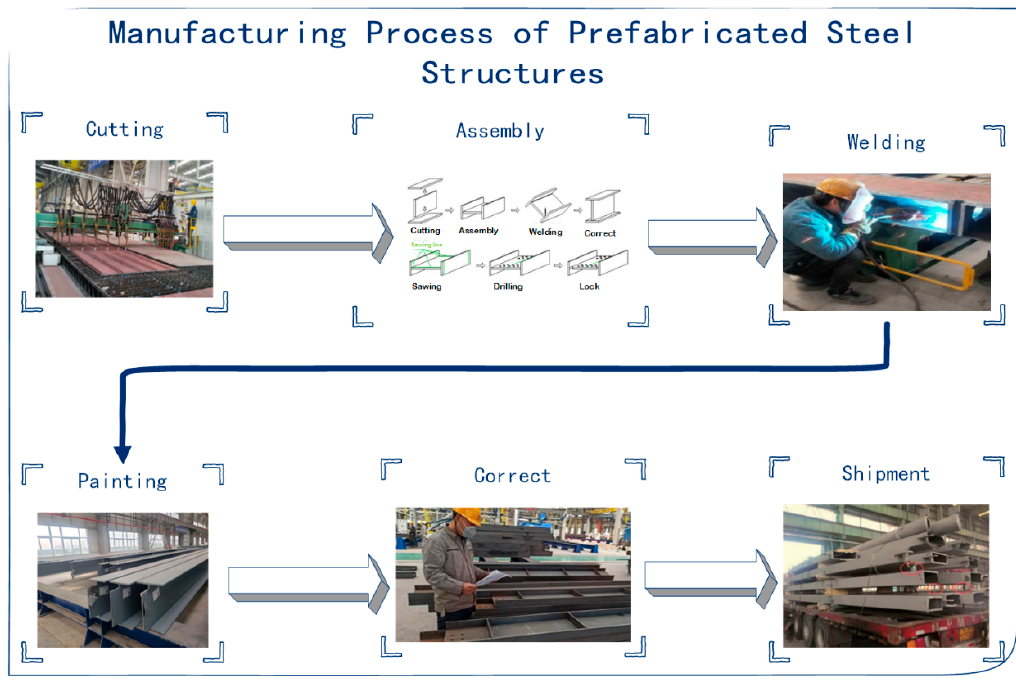
Figure 2. Manufacturing processes.